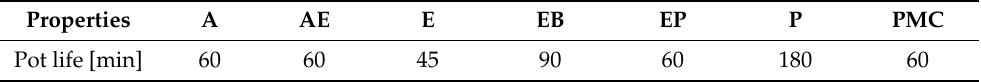
Table 4. Pot life of coatings.